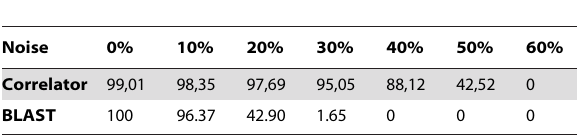
Table 5. Sensitivity (%) of the Correlator and BLAST